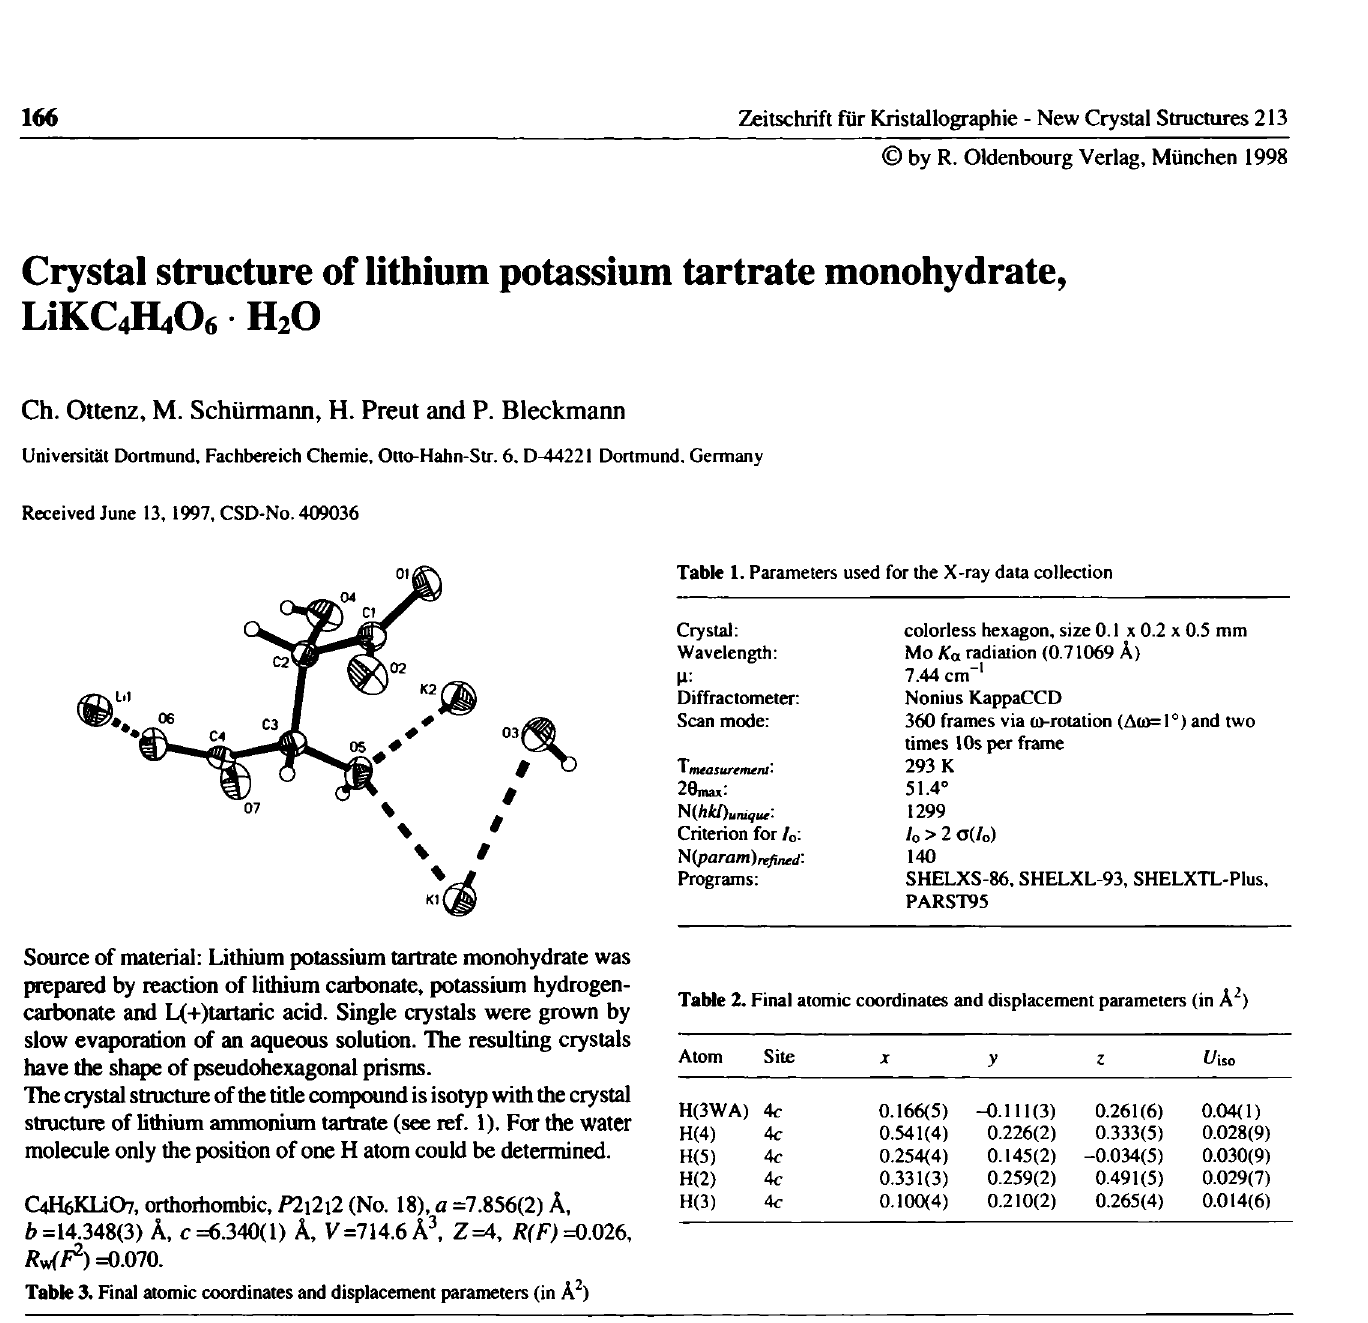
Table 3. Final atomic coordinates and displacement parameters (in A^)